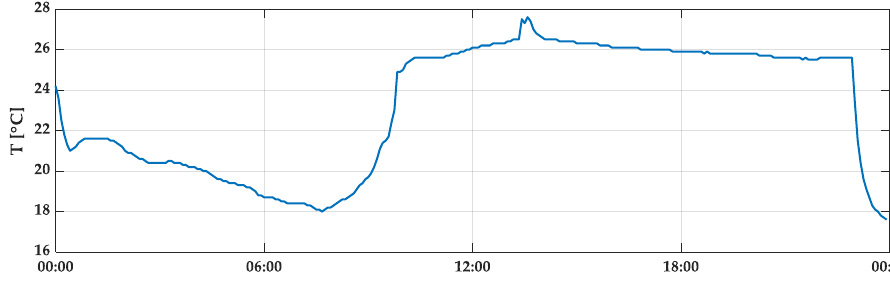
Figure 35. Records of air temperature.